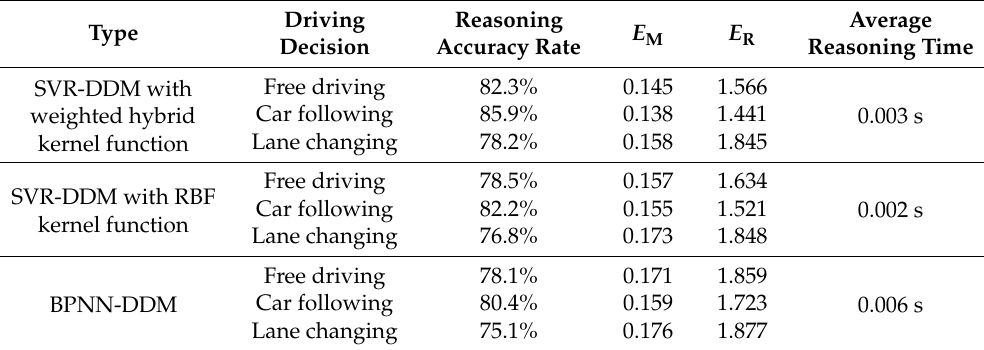
Table 5. The results of three DDMs without considering road